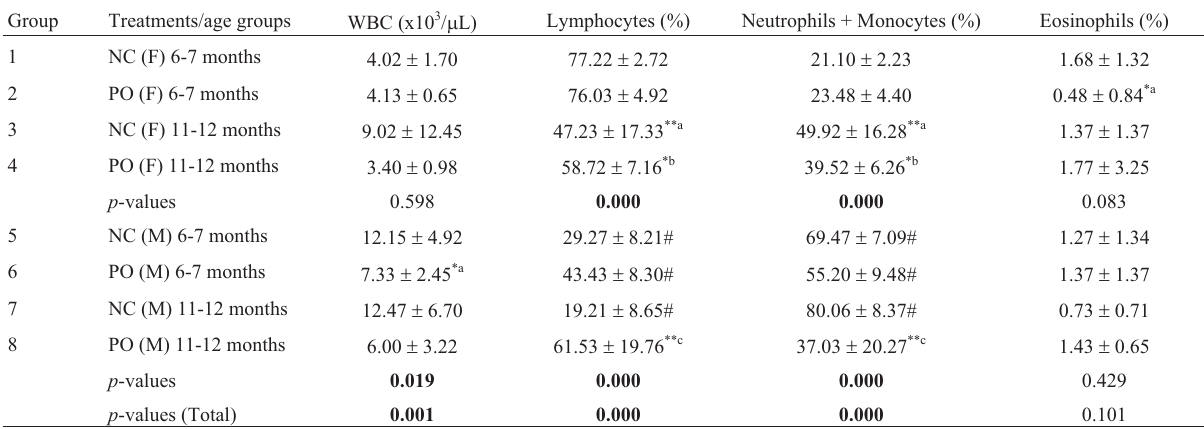
Table 4 - Results of leukogram of elderly female (F) and male (M) Swiss albino mice after treatment with pequi oil (30 mg/animal/day) administered orally for 15 consecutive days. Negative controls (NC) received filtered water administered in the same way.